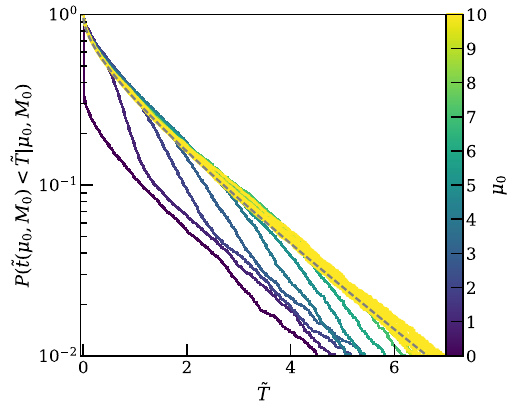
Fig. 6 Probabilities estimated with toy-MCs for the test statistic ˜ t (μ , M ) of Eq. (4) to be smaller than a threshold value ˜ T for a simpli- 0 0 fiedLXeTPClikelihood,varyingthetruesignalexpectation μ 0 between 0 and 10 events, for a M 0 = 1000 GeV / c 2 SI WIMP. The dashed black line shows the asymptotic χ 2 result for large signal expectations. For 1 small signal sizes (darker colored lines), the asymptotic approximation deviates significantly from the true p